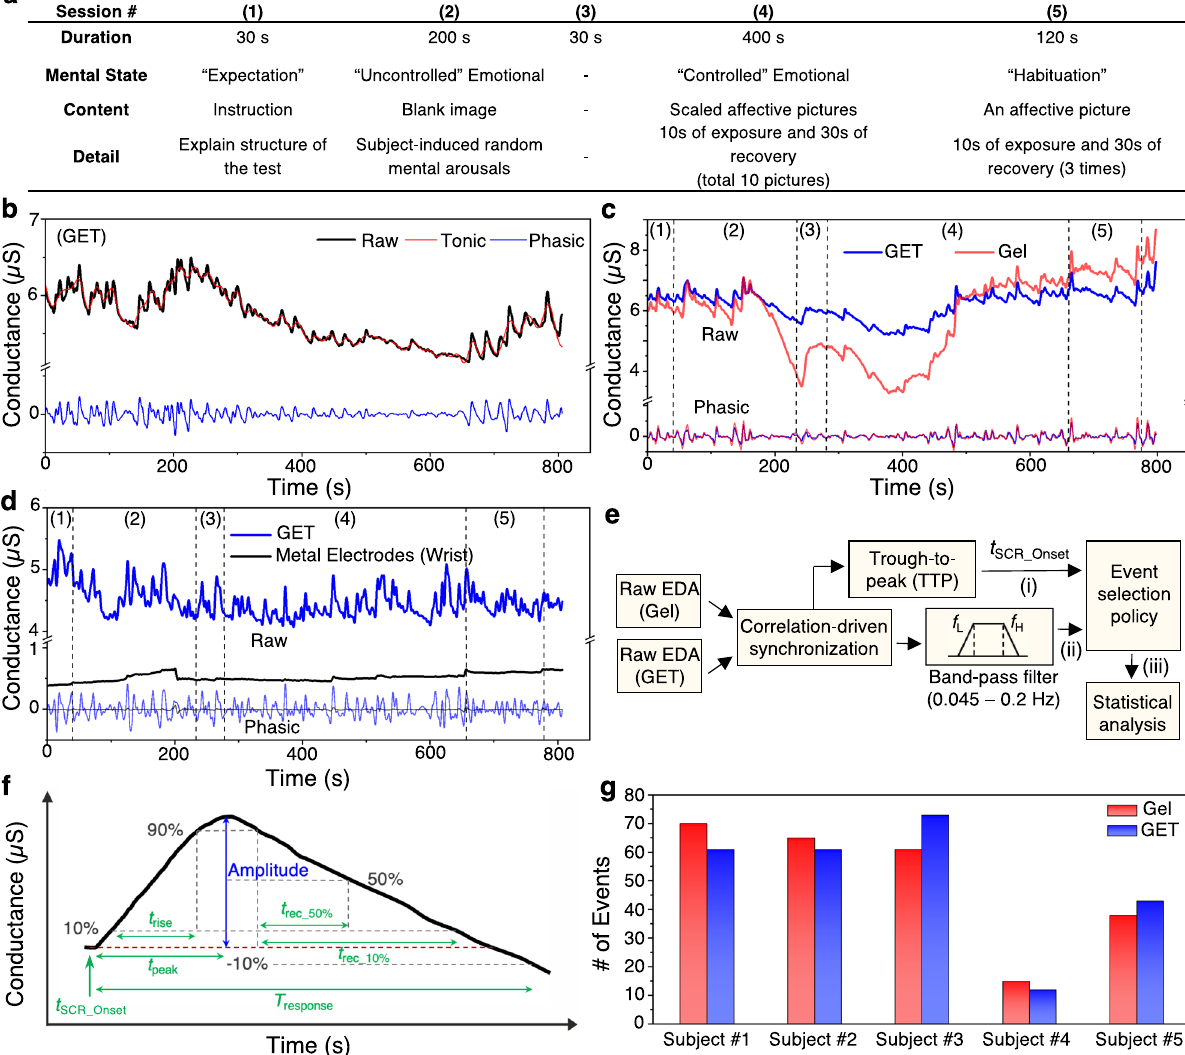
Fig. 5 | EDA measurement and correlation analysis. a An EDA testing video consisting of fi ve different sessions – Expectation, “ Uncontrolled ” Emotional, Expectation (identical as session #1), “ Controlled ” Emotional, and “ Habituation. ” b Raw data and decomposed data of EDA measured by the GET sensor. c ComparisonofEDAmeasuredbyGET(blue)vs.gelelectrodes(red)onsubject#1.